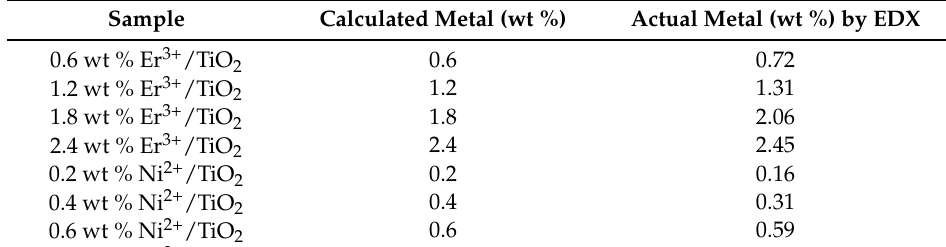
Table 4. Calculated and actual wt % of Er and Ni on TiO 2 surface using energy dispersive X-ray (EDX).